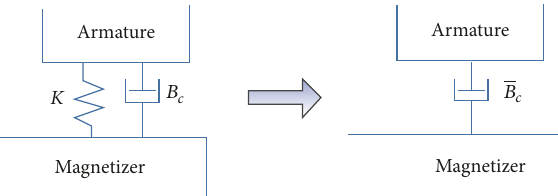
Figure 11: The simplified physical model of